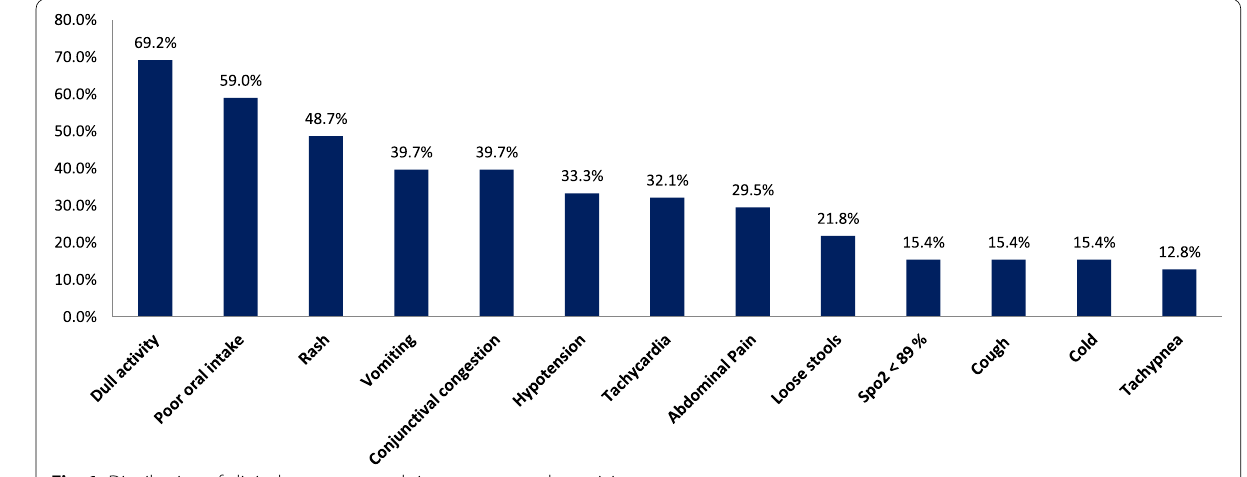
Fig. 1 Distribution of clinical symptoms and signs among study participants